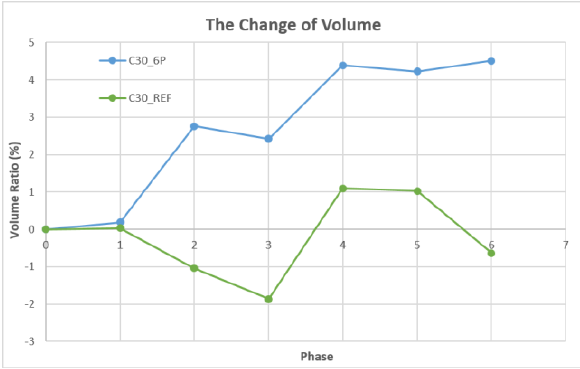
Figure 8. Lateral expansions of C30 6P